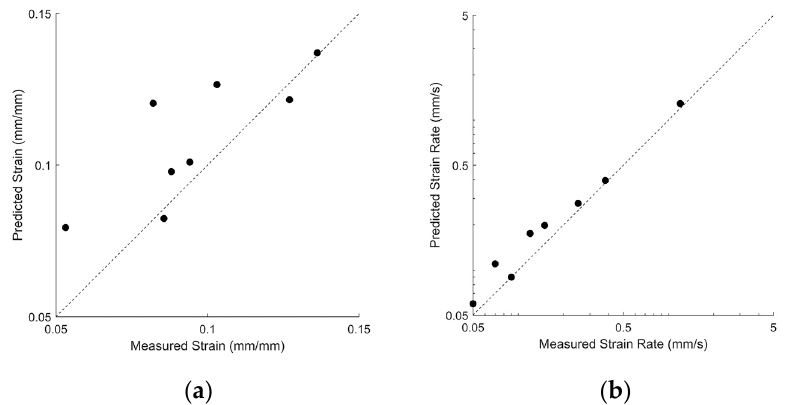
Figure 10. ( a ) Scatterplot of the true strain compared to the predicted model strain for different